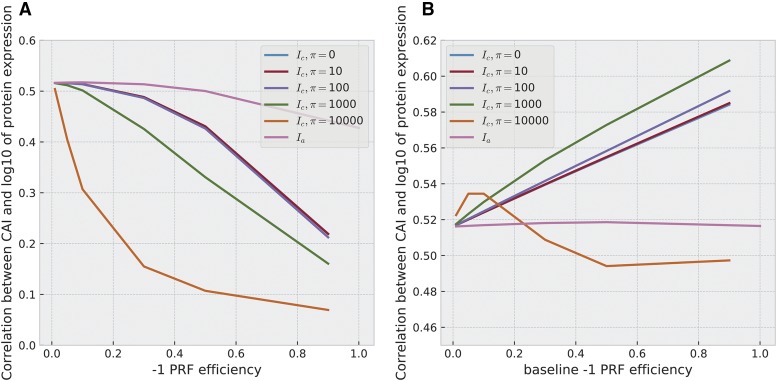
Correlation values between corrections of CAI to -1 PRF presence (Ic^,Ia) to protein expression levels P (von der Haar 2008) for different -1 PRF efficiencies, p. A) For Ic^, we considered different values of π, the cost of degrading an mRNA after -1 PRF, namely π=0,10,100,1000,10000. For Ic^, correlation values were computed at -1 PRF efficiencies p=0.01,0.05,0.1,0.3,0.5,0.9.
Ia was computed at the same levels except for p=0.9, where instead p=1 was used. B) Analogous to A), but with p dependent on protein expression. For each gene, the -1 PRF efficiency is computed by p(P)=pb/log10(P), where for pb, the baseline -1 PRF efficiency, we chose the same values as for p in A).